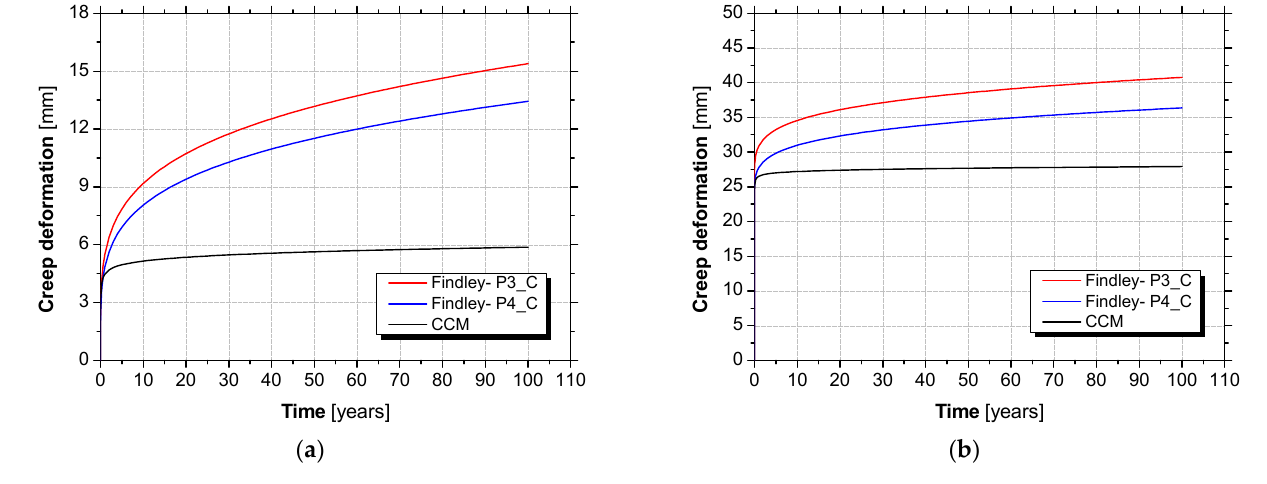
Figure 17. Composed creep model versus experimental results: ( a ) creep deformation and ( b ) total deformation.